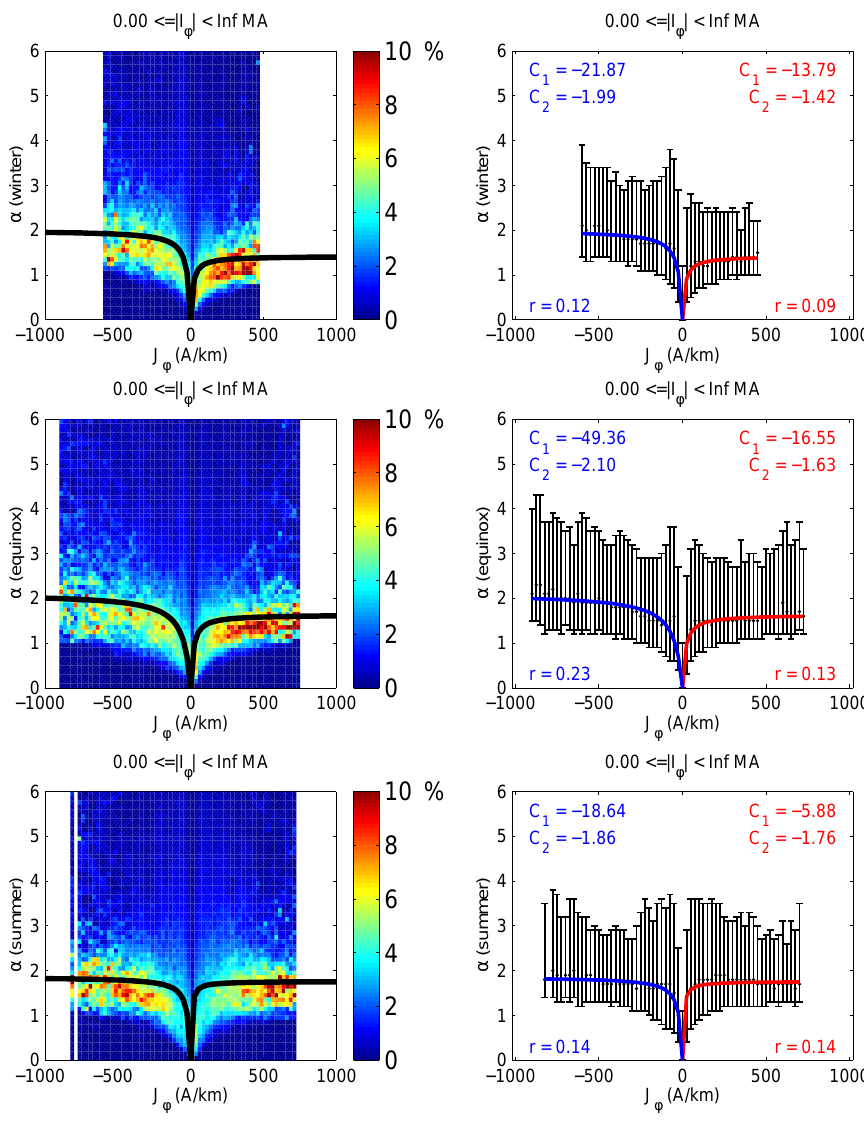
Fig. 14. The same as Fig. 13, except that instead of activity, the data are binned with respect to season: winter ( top, left ), equinox ( top, right ) and summer ( bottom, left ).